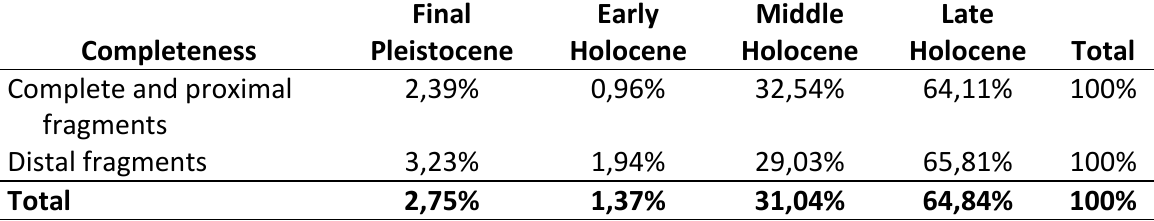
Figure 5. Lithic tools. Late Holocene, CDM1. a. bifacial projectile point, b. fragment of bifacial projectile point, c. end scraper-point, d. retouched flake. Table 4. Proportion of flakes with platform.